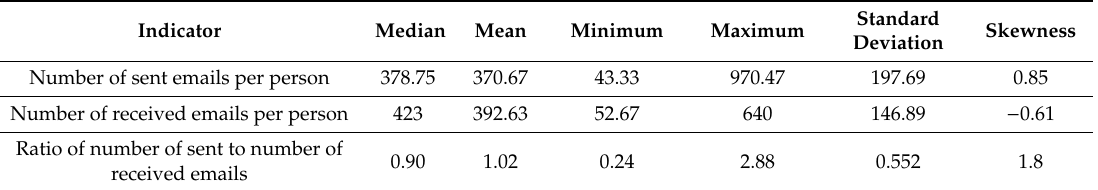
Table 3. Basic email activity indicators, department